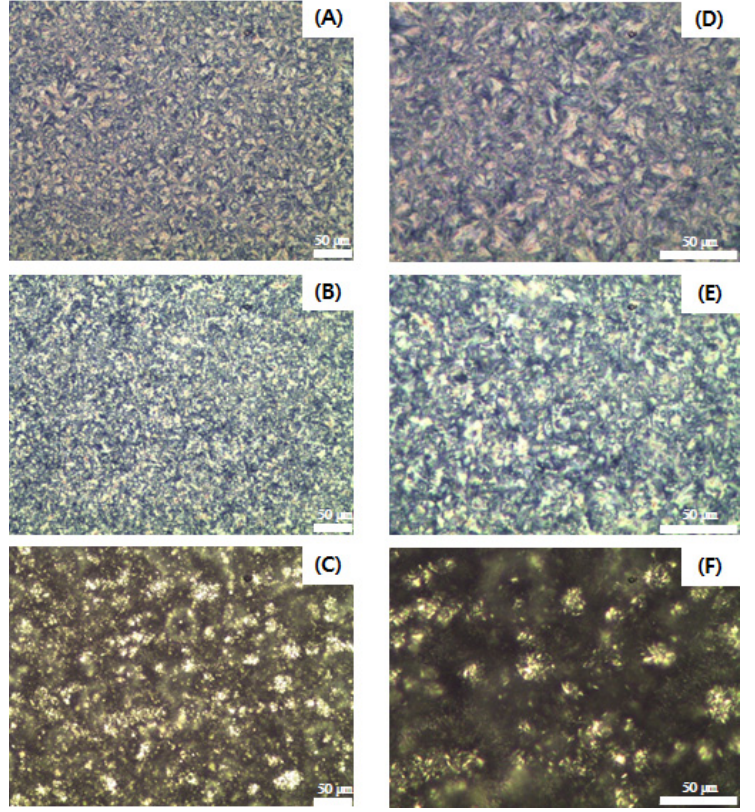
Figure 4. Polarized light micrographs of SSS-rich fat (( A ): ×20, ( D ): ×40), SSO-rich fat (( B ): ×20, ( E ): ×40), OSO-rich fat (( C ): ×20, ( F ): ×40). The scale bar represents 50 μ m.